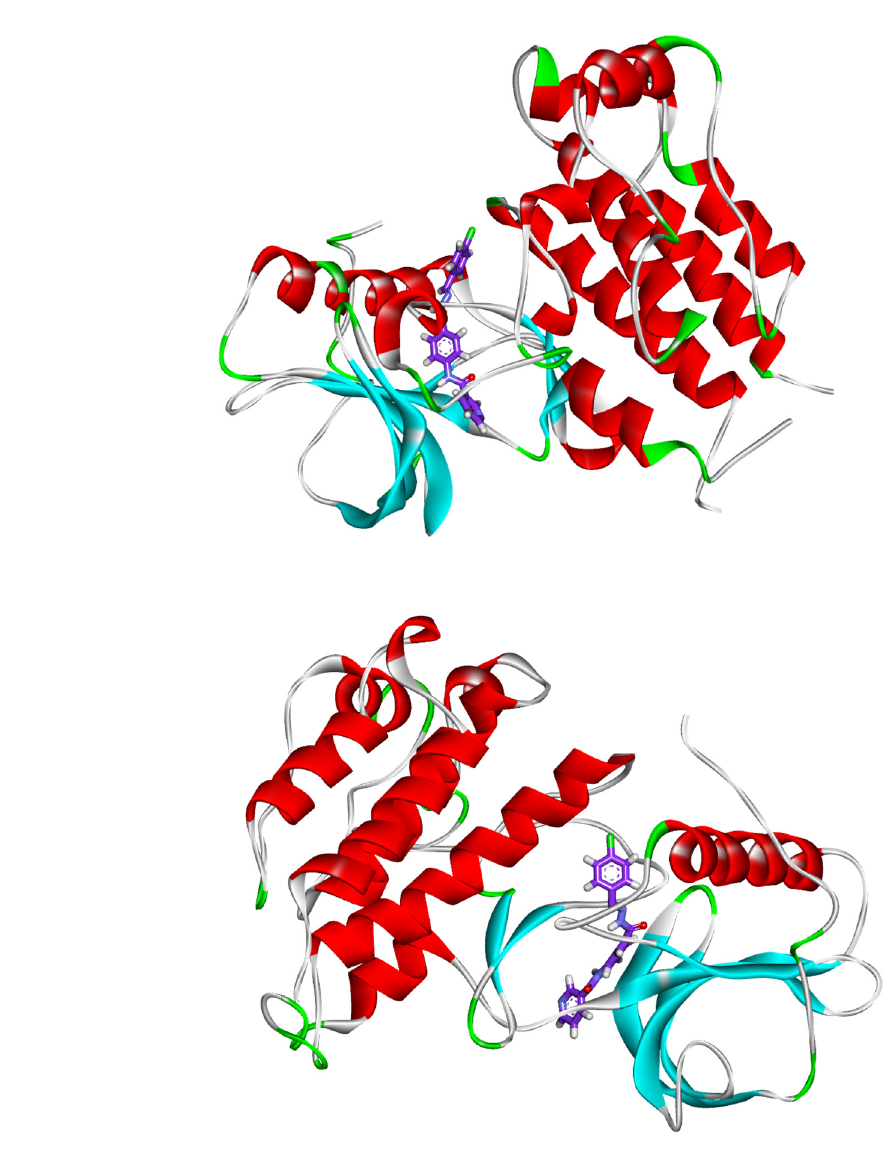
Figure 10. Ribbon diagrams of compound 6 -VEGFR-2 complex at ( A ) 1st ns and ( B ) 100 th ns indicating the incidence of some conformational changes in the VEGFER-2 and the stability of compound 6 inside the active pocket of VEGFER-2 over the MD run (100 ns).